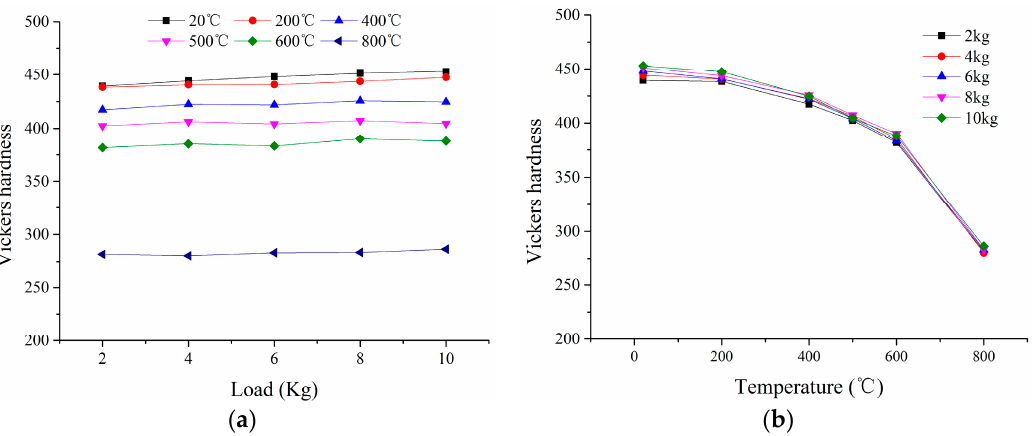
Figure 13. The Vickers hardness under different loads ( a ) and temperatures ( b ).